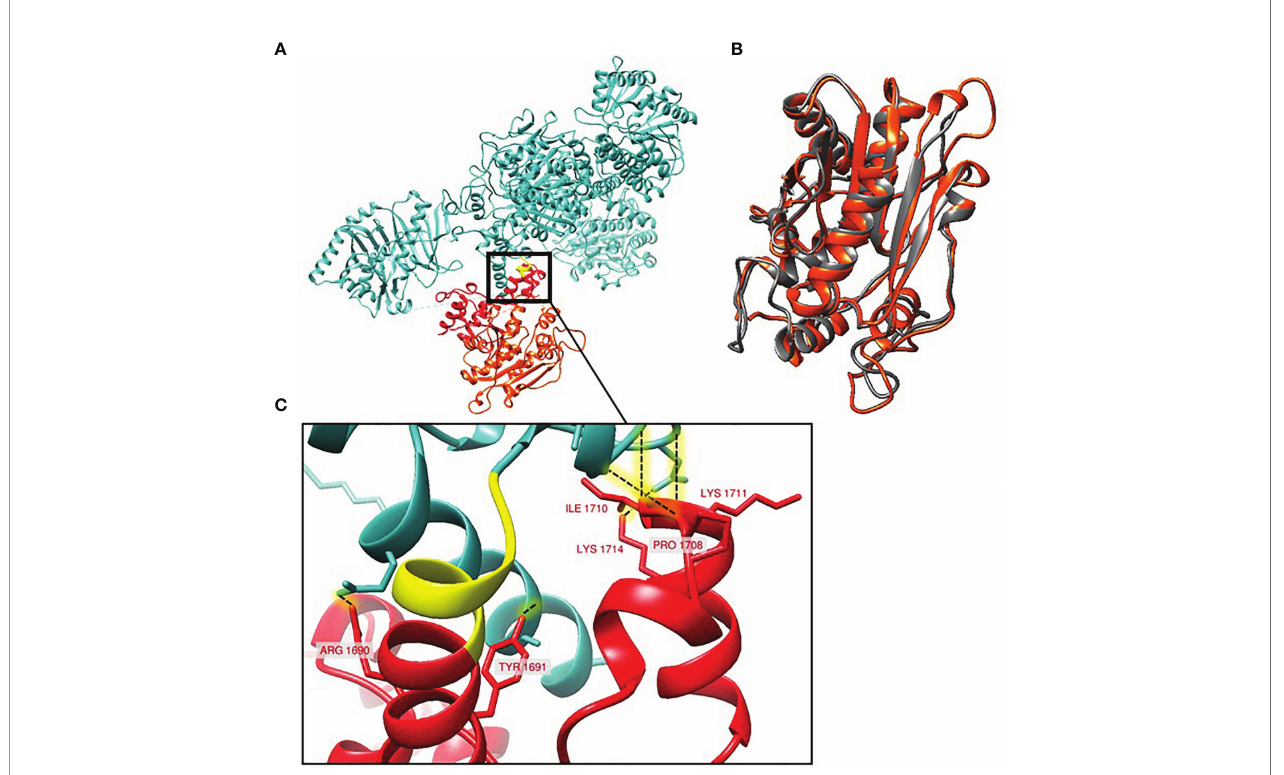
FIGURE 4 | Structural model of A. fumigatus PksP protein. (A) The conserved region between the green-spore and white-spore isolates (blue) and the region affected by the frameshift variant observed in the white-spore isolates (yellow and red). The yellow region represents the 6 amino acids altered by the frameshift mutation. The red region represents the portion of PksP deleted in the white-spore isolates; the terminal red-orange region corresponds to the predicted thioesterase domain. (B) Structural superposition (0.987Å RMSD) between the crystal structure of the thioesterase domain of Aspergillus parasiticus PksA (gray) and the predicted A. fumigatus PksP thioesterase domain (red-orange). (C) Hydrogen bonding (dashed lines) within the fi rst PP domain of PksP that aren ’ t in the truncated